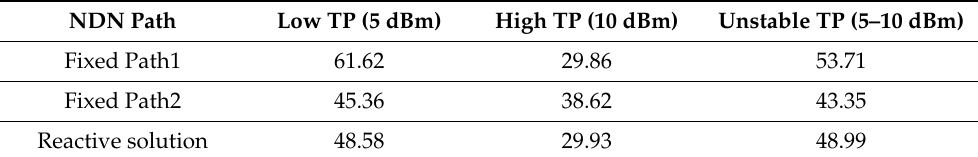
Table 2. Average of Interest-Data exchanges performance delay (msec).